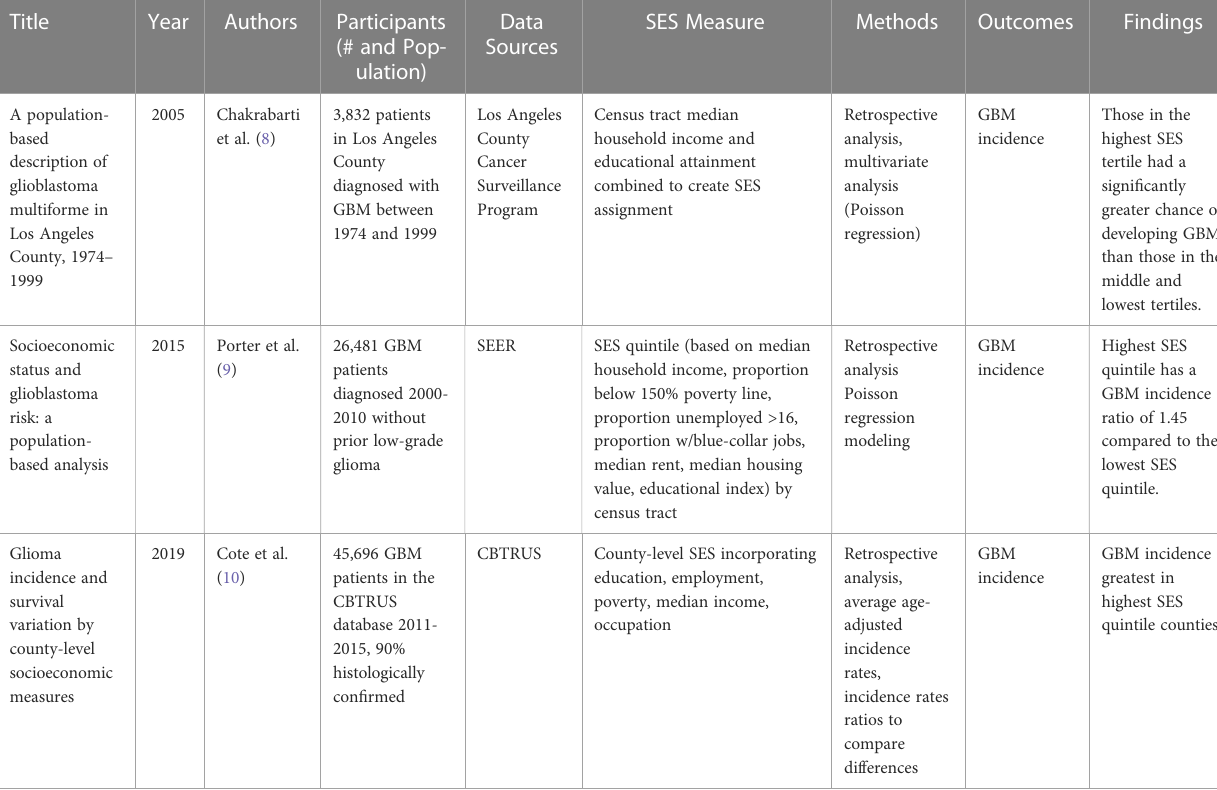
TABLE 1 Area-level socioeconomic status and GBM